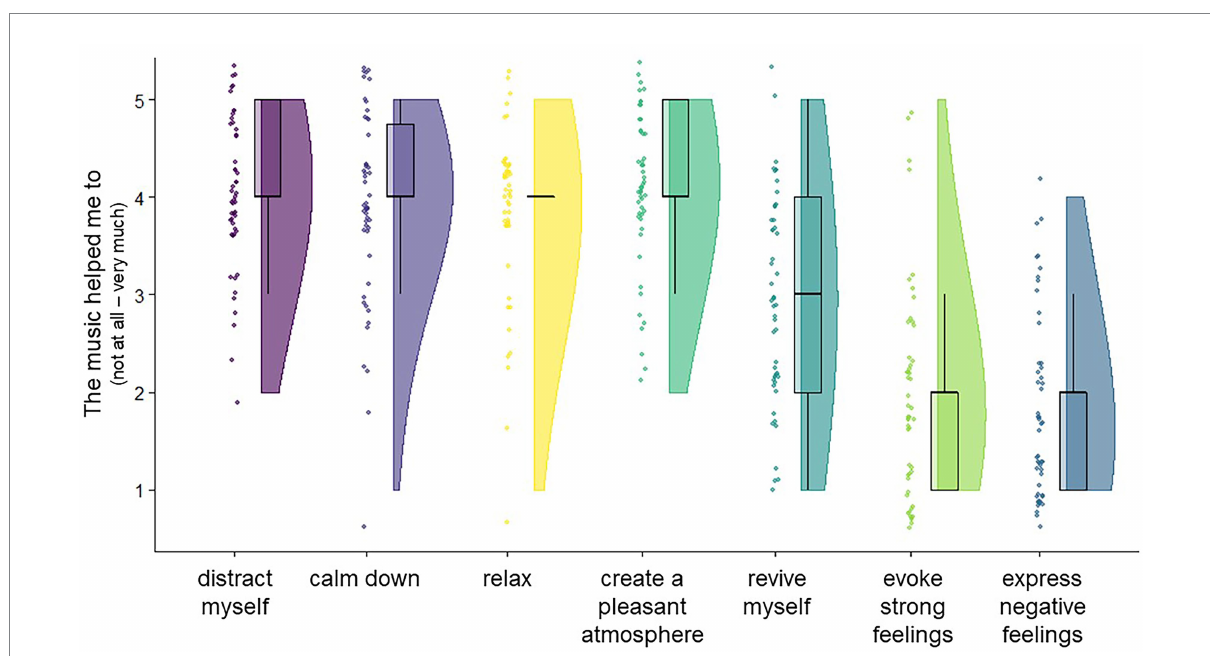
FIGURE 3 Perceived effects of music listening when following the encouragement to listen to music in moments of stressful experiences. Participants’ responses provided at